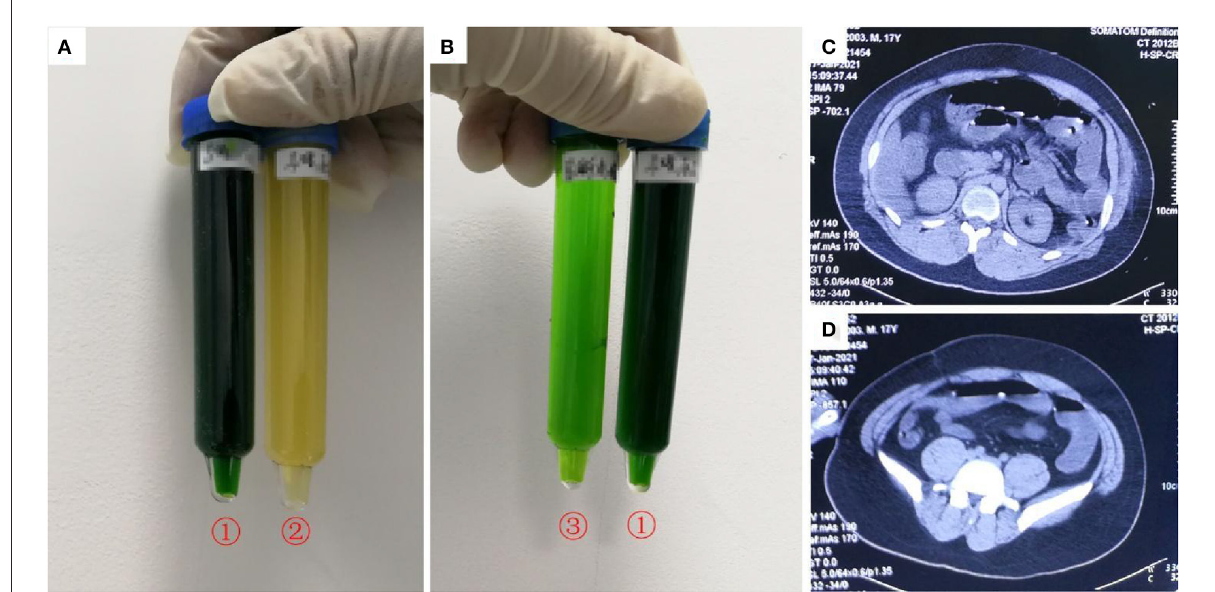
FIGURE1 Images of urine and computerized tomography (CT) for the 21-year-old man who ingested ∼ 200mL of diquat. As shown in (A,B) , after exposure to sodium dithionite, the patient’s urine turned dark green (tube no. 1); the patient’s original urine was darker in color (tube no. 2); the patient’s urine turned light green after dilution (tube no. 3). (C,D) Shows partial intestinal gas and dilatation at the fluid